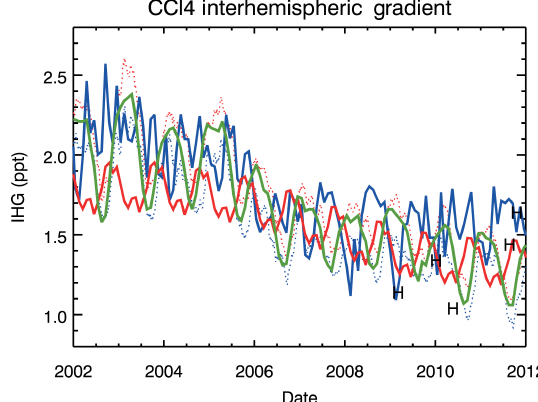
Figure 9. Observed interhemispheric gradient (IHG) of CCl 4 (north–south, ppt) from monthly-mean AGAGE (red line) and NOAA (blue line) observations. The NOAA IHG is estimated by binning the station data by latitude and applying a cosine(latitude) weighting. The AGAGE IHG is estimated from output of a 12-box model which assimilates the observations. Also shown are results from the model tracer CTC1 sampled over the whole model domain (green line), sampled at the AGAGE station locations (red dotted line) and sampled at the NOAA station locations (blue dotted line). The H symbols show the IHG estimated from the five HIPPO cam- paigns (see Table